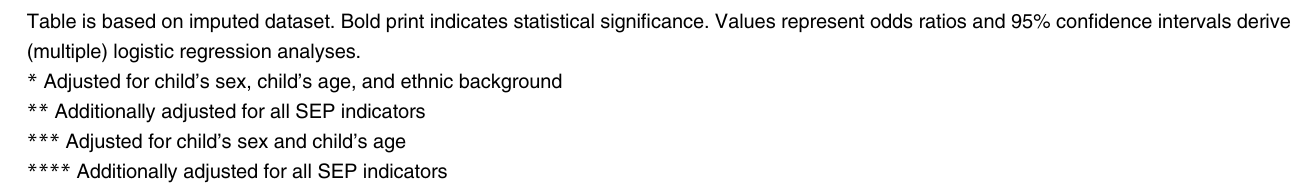
Table is based on imputed dataset. Bold print indicates statistical signi fi cance. Values represent odds ratios and 95% con fi dence intervals derived from (multiple) logistic regression